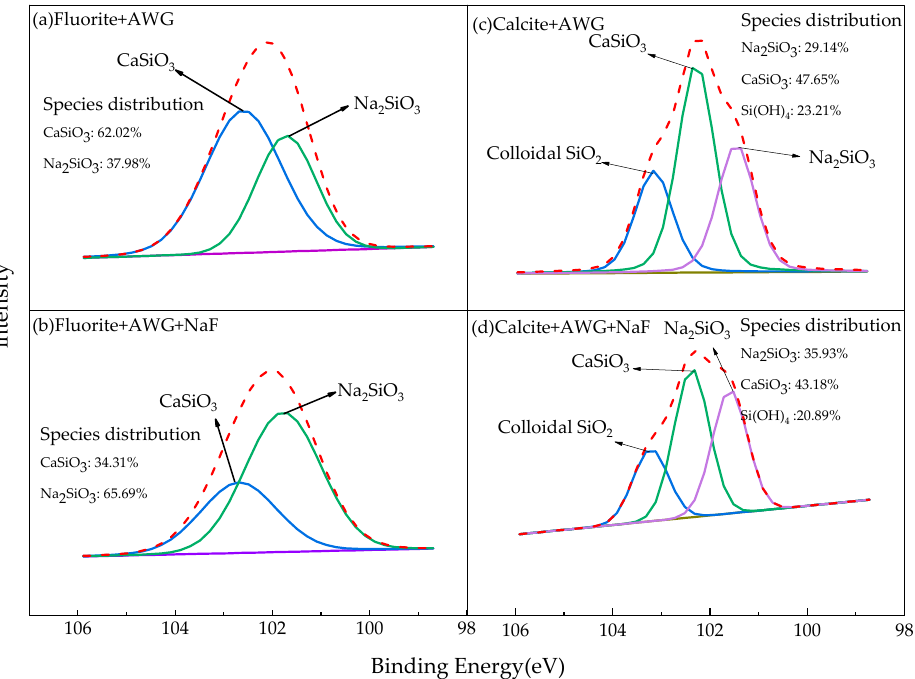
Figure 6. Si2p XPS spectra of ( a ) AWG-treated fluorite surface, ( b ) AWG + NaF-treated fluorite surface, ( c ) AWG-treated calcite surface, and ( d ) AWG + NaF-treated calcite surface.